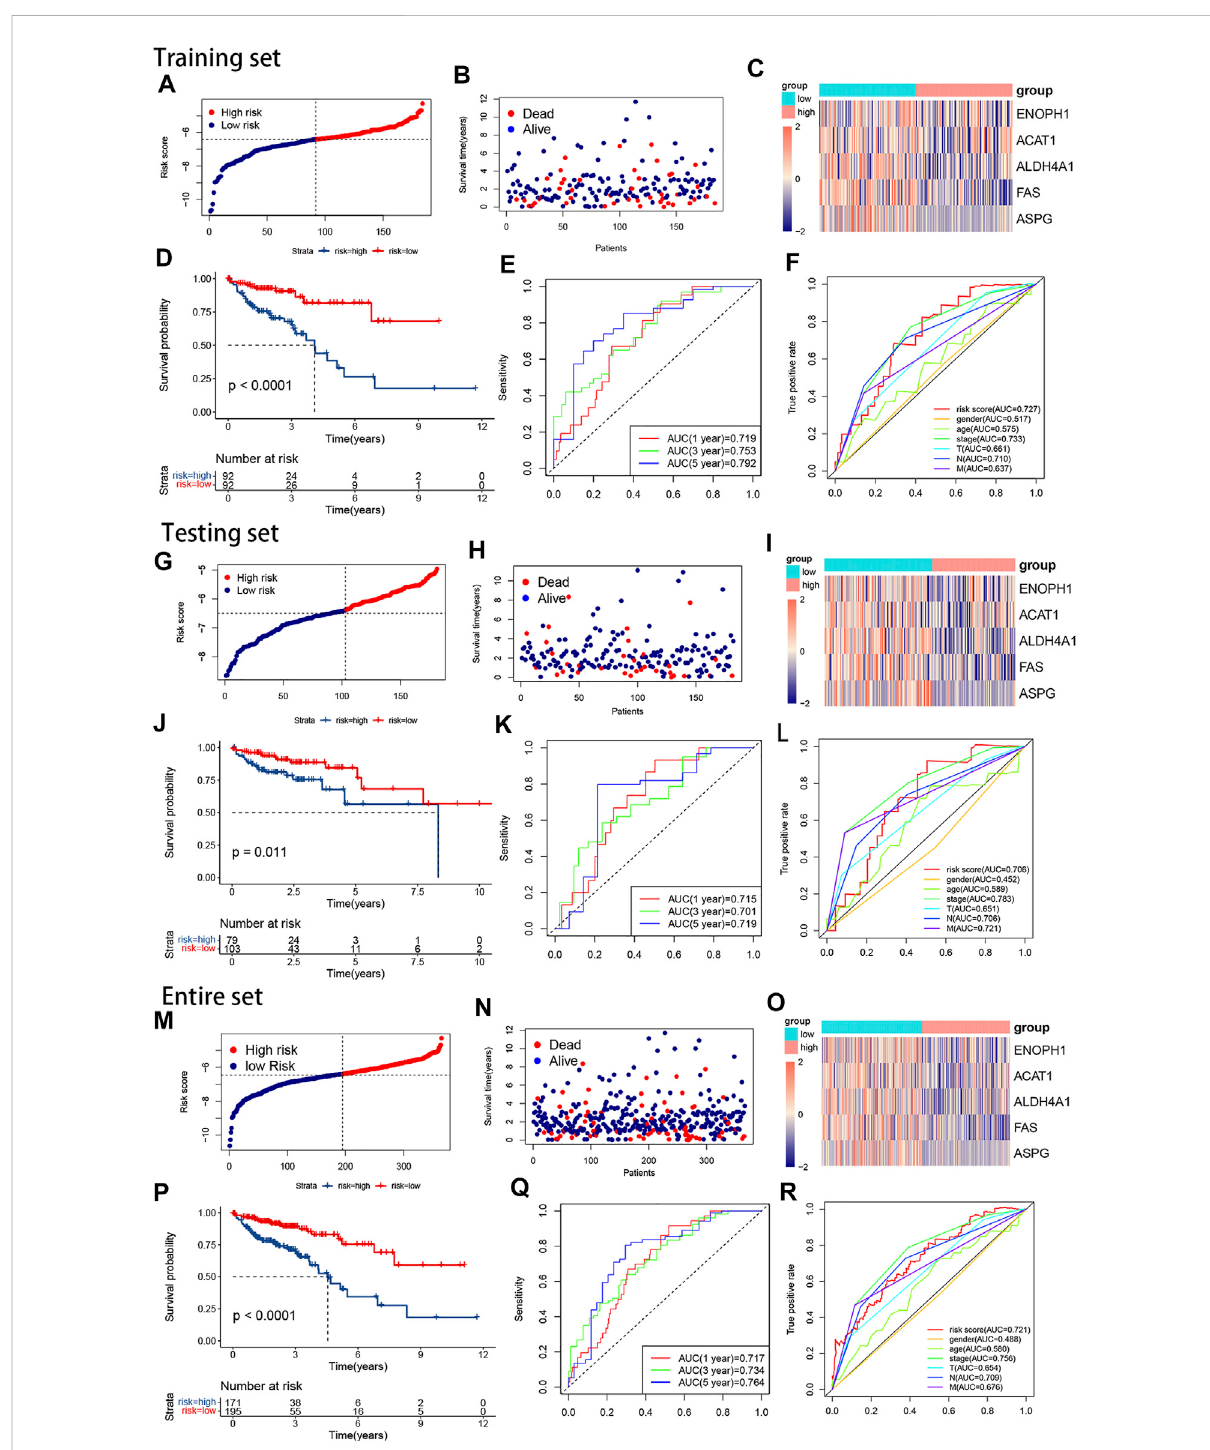
FIGURE 3 The plots of survival analyses, the distribution of patients ’ survival times and survival status, and the heatmap of the expression of the fi ve AAMRGs in the training set, the testing set, and the entire set, respectively. (A,G,M) The plots of risk score in the training set, the testing set, and the entire set, respectively. (B,H,N) The distributions of patients ’ survival times and survival status in the training set, the testing set, and the entire set, respectively. (C,I,O) . Heatmaps of the expression matrix of the fi ve AAMRGs in the training set, the testing set, and the entire set, respectively. (D,J,P) KM curves in the training set, the testing set, and the entire set, respectively. (E,K,Q) Time-dependent ROC curves in the training set, the testing set, and the entire set, respectively. (F,L,R) Clinical feature ROC curves in the training set, the testing set, and the entire set,